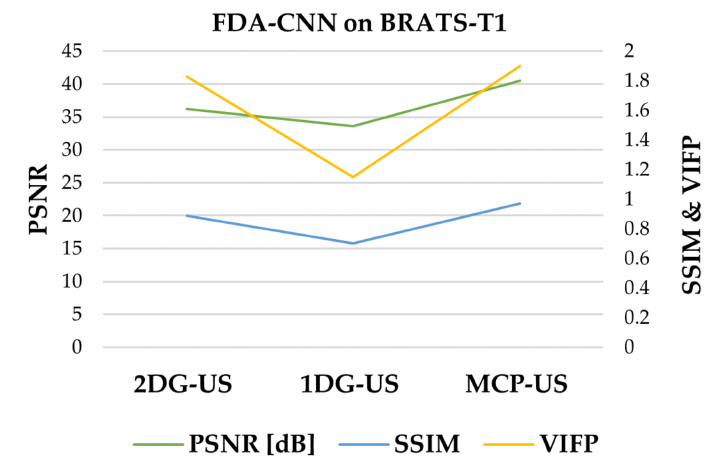
Figure 9. Comparison of three sampling patterns using